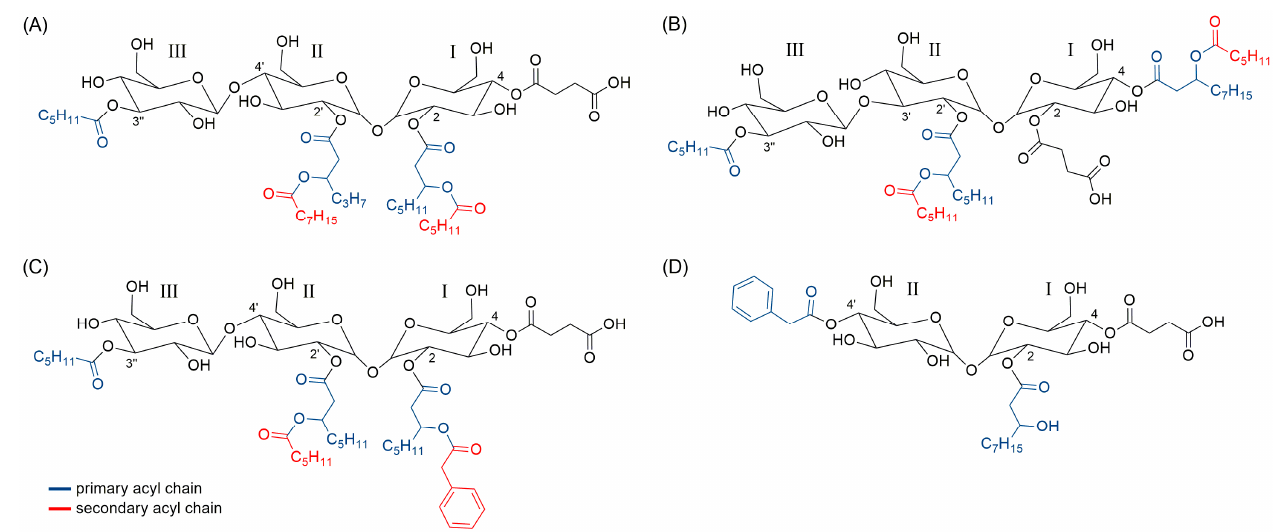
Figure 9. Succinoyl saccharide esters from Rhodococcus species. ( A , B ) Chemical structures of the succinoyl trisaccharide tet- raesters isolated from the deep-sea Rhodococcus sp. BS-15 ( A ) and an unclassified Rhodococcus species, annotated as ‘isolate Q’ ( B ). These biosurfactants have a hydrophilic backbone consisting of two α , α − 1,1 glycosidic linked glucose units, i.e., trehalose, which bears a third β -glucose unit (III) with a hexanoate at C3 ″ . The trehalose moiety is acylated at C2/C2 ′ and C4/C4 ′ with succinate and O -ester-linked acyloxyacyl motifs. ( C , D ) Putative structures of a representative succinoyl trisaccharide tetraester ( C ) and a succinoyl disaccharide triester ( D ) from Rhodococcus sp. I2R discussed in this study. Positions of substituents linked to the saccharide backbone have been assigned according to compound A .